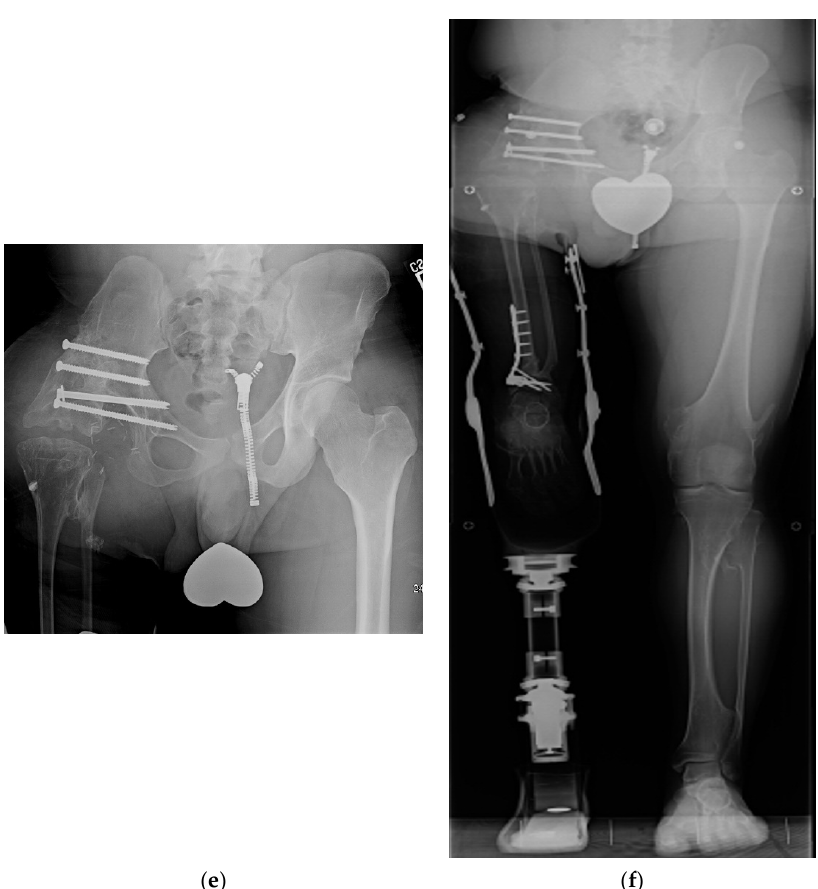
Figure 2. ( a ) Illustration of CFD Paley type 3 ( a or b ), ( b ) Illustration after Brown rotationplasty for Paley type 3 ( a or b ), ( c ) AP pelvis x-ray of 14-year-old boy with Paley type 3b CFD, ( d ) Preop standing erect leg x-ray of same boy, showing that the ankle is at the level of the opposite knee (incidentally this patient also has multiple osteochondromas), ( e ) AP pelvis radiograph in same boy, 7 years after healed Brown rotationplasty, ( f ) Sanding radiograph with prosthetic 7 years after Brown rotationplasty with supramalleolar osteotomy for ankle realignment. Clinically he has excellent gait and function.